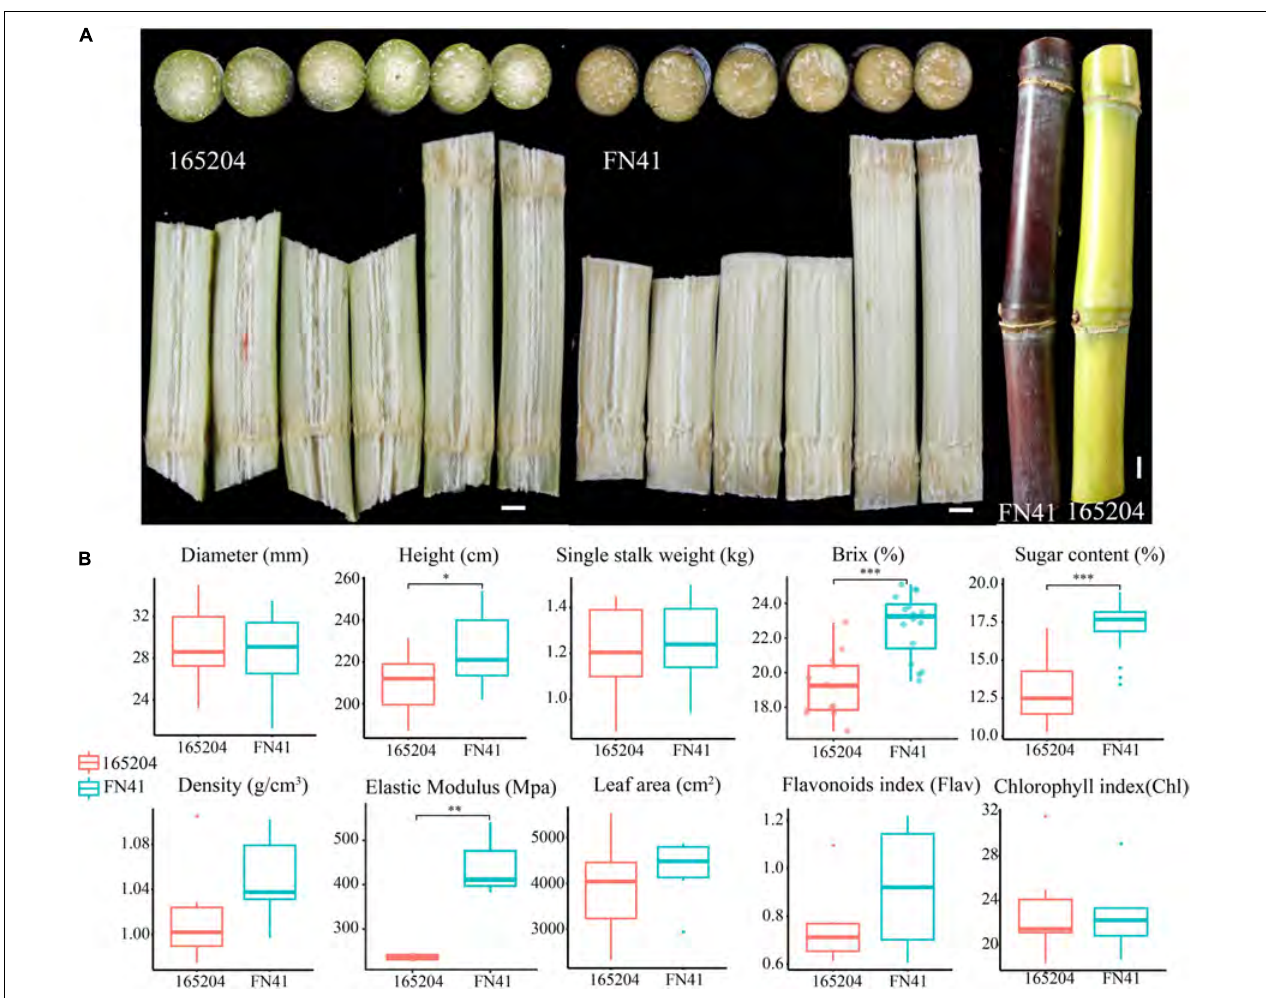
FIGURE 1 | Physiological characteristics of FN41 and 165204 sugarcane cultivars, bar = 1 cm (A) ; Comparison of agronomic traits between FN41 and 165204 (B) . * p < 0.05, ** p < 0.01, and *** p < 0.001.